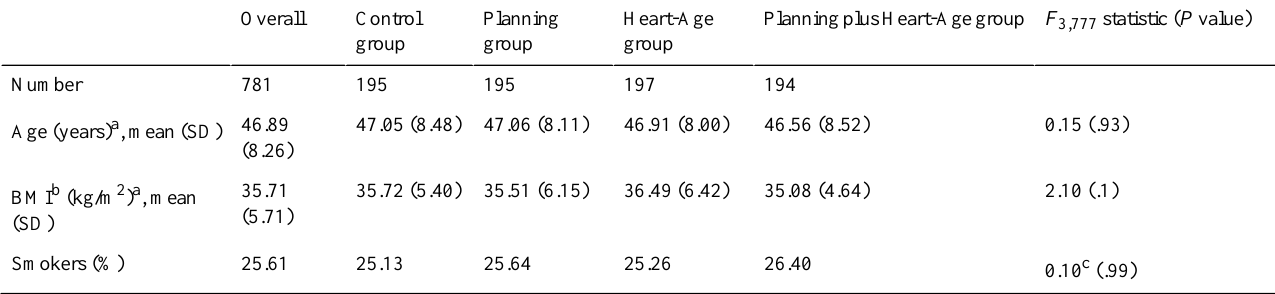
Table 1. Participants’baseline